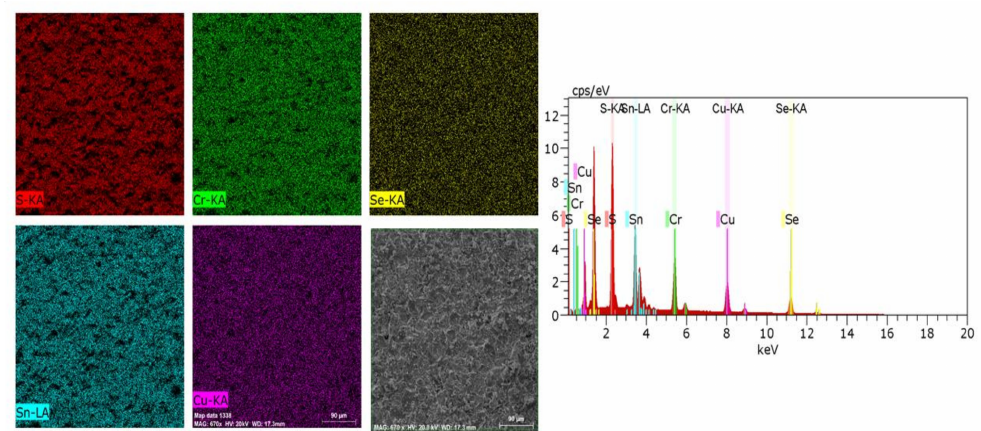
Figure 1. SEM analysis: Representative EDS mapping images (powder sample) and backscattered electron image of Cu 1 . 0 Cr 1 . 0 Sn 1 . 0 S 1 . 7 Se 2 . 3 (20 kV, 670 × ).